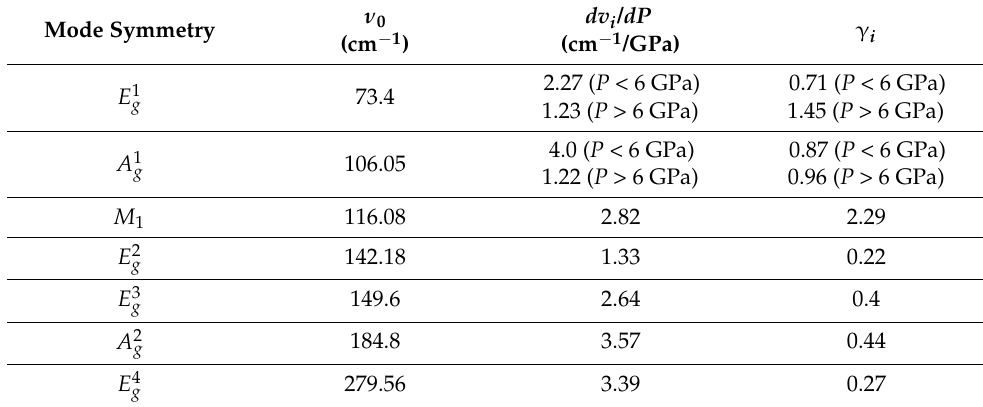
, where B 0 is the T